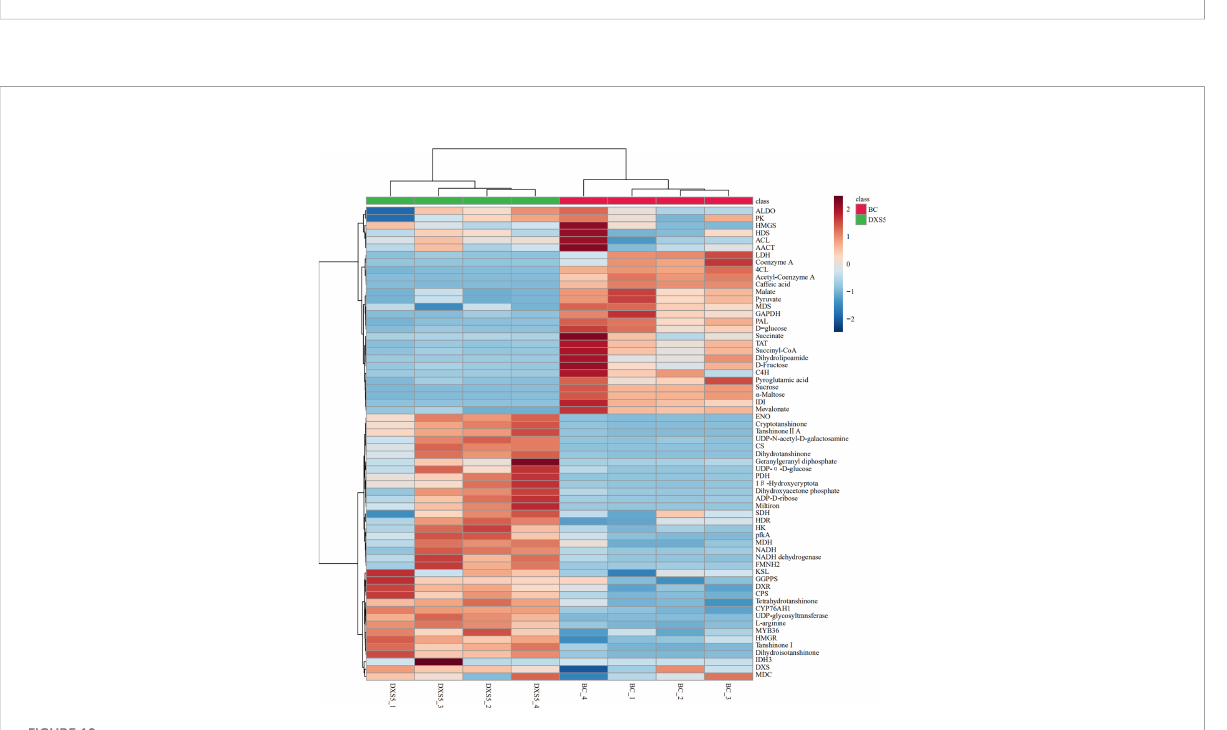
FIGURE 10 Heatmap based on hierarchical clustering